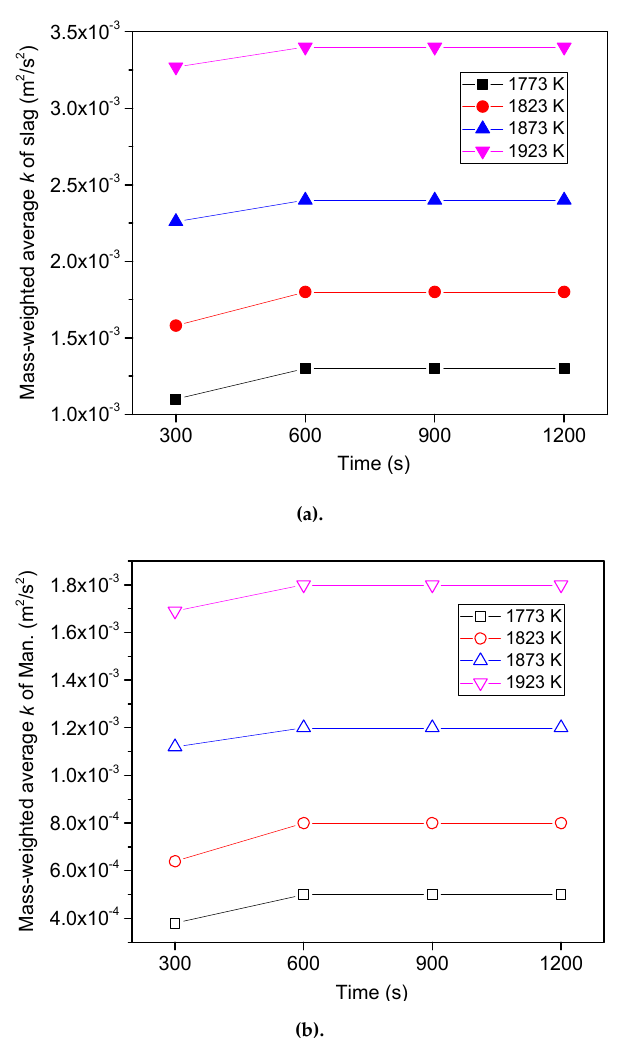
Figure 13. Effect of heating temperature on mass-weighted average turbulence kinetic energy of melt ( a ) molten slag, and ( b ) molten manganese. A higher temperature significantly promotes the action of the melt, as indicated in Figure 13. The turbulence kinetic energies of the molten slag and the molten manganese also become steady after 600 s. The final turbulence kinetic energy of the molten slag and the molten manganese ascends from 1.3 × 10 − 3 m 2 /s 2 to 3.4 × 10 − 3 m 2 /s 2 and from 5.1 × 10 − 4 m 2 /s 2 to 1.8 × 10 − 3 m 2 /s 2 when the heating temperature ranges from 1773 K to 1923 K. The growth rate of the turbulence kinetic energy also becomes larger with increasing heating temperature. The turbulence kinetic energy of the molten slag increases by 38.5% when the heating temperature changes from 1773 K to 1823 K, while it increases by 41.7% when the heating temperature is changed from 1873 K to 1923 K. Due to having a larger viscosity, the diffusion of sulfur in the molten slag is supposed to be the rate-limiting step for the desulfurization. In this regard, the desulfurization of the rejected EMM could be promoted if the temperature of the molten slag were elevated.